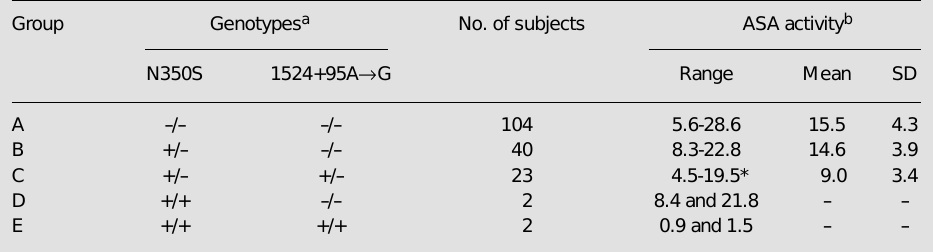
Table 1 - Genotypes and ASA activity in different groups of the study population. a: -/- Indicates homozygotes for the normal sequence; +/- indicates heterozygotes; +/+ indicates homozy- gotes for the mutant sequence. b: ASA activities are reported as nmol h -1 mg protein -1 . SD = Standard deviation. *P<0.05 compared to groups A and B